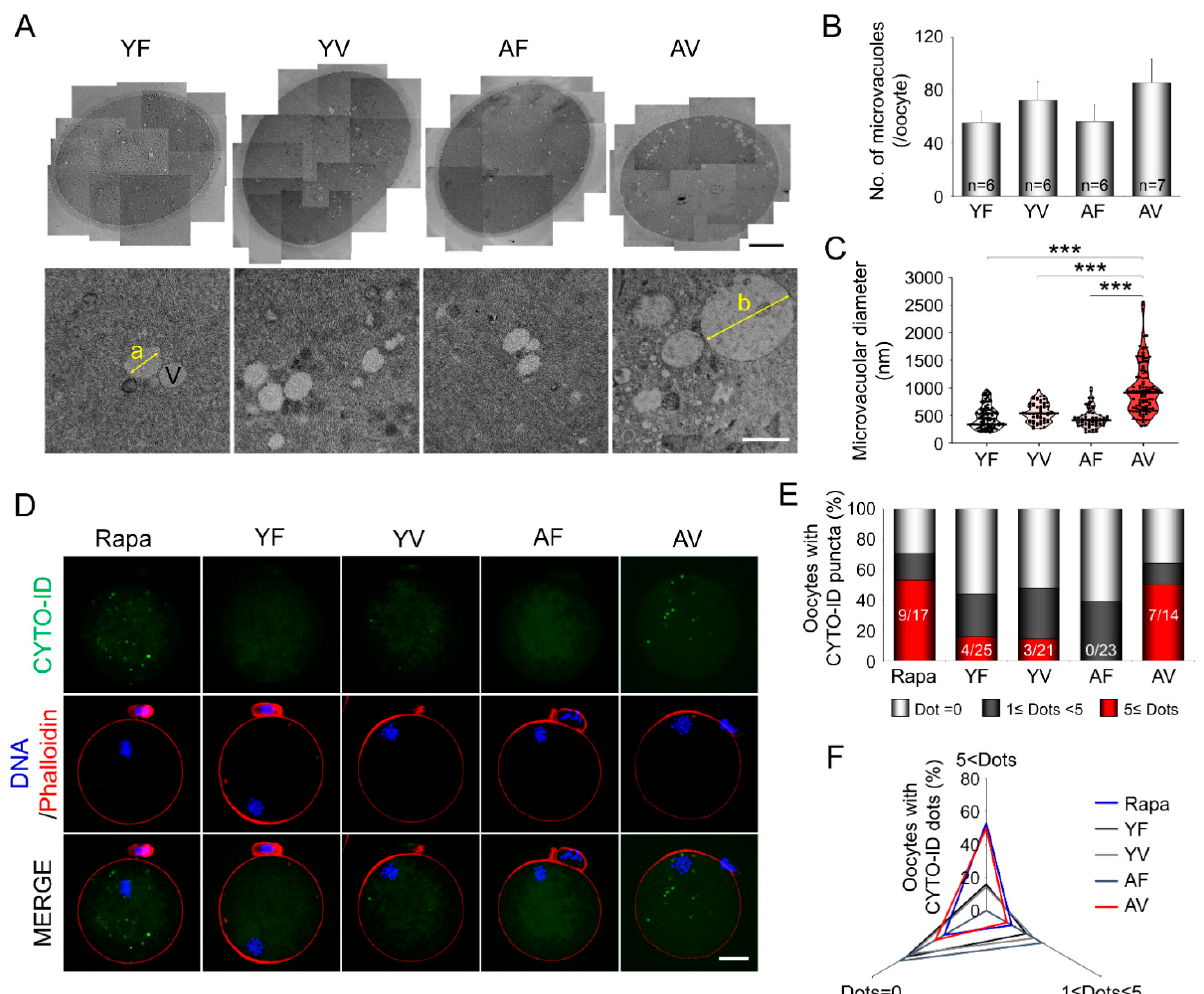
Figure 4. Ultrastructural analyses of fresh and vitrified/warmed (VW) oocytes from young and aged mice. ( A ) Transmission electron microscopy images showing the microvacuoles in fresh and VW oocytes (a = 722 nm, b = 1910 nm). Upper panel scale bar = 12 µ m; Bottom panel scale bar = 1 µ m. ( B , C ) Quantitative analyses for the diameter and number of microvacuoles in fresh and VW oocytes from young and aged mice ( n = 6–7 oocytes in each group). Note that the size and number of microvacuoles increased in VW oocytes from aged mice. The horizontal black lines represent the median values of the microvacuolar diameter of oocytes. Statistical comparisons were performed using one-way ANOVA, followed by Tukey’s multiple comparisons test and Dunn’s multiple comparisons test. V: Microvacuole. *** p < 0.005. ( D ) Representative microscopic images of autophagosome visualized using CYTO-ID (Green) in oocytes from young and aged mice before or after vitrification. Confocal imaging analysis of the oocytes. ( E , F ) Quantitative analysis of CYTO-ID puncta in fresh and VW oocytes from young and aged mice ( n = 14–25 oocytes in each group). YF: Young fresh, YV: Young vitrified, AF: Aged fresh, AV: Aged vitrified.